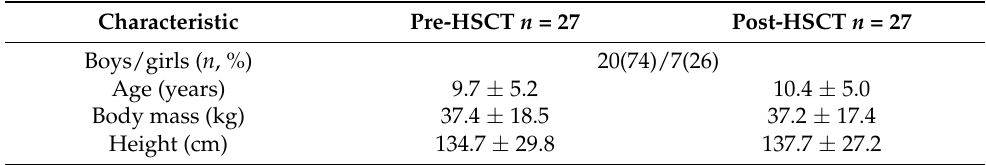
Table 4. Clinical data of the study